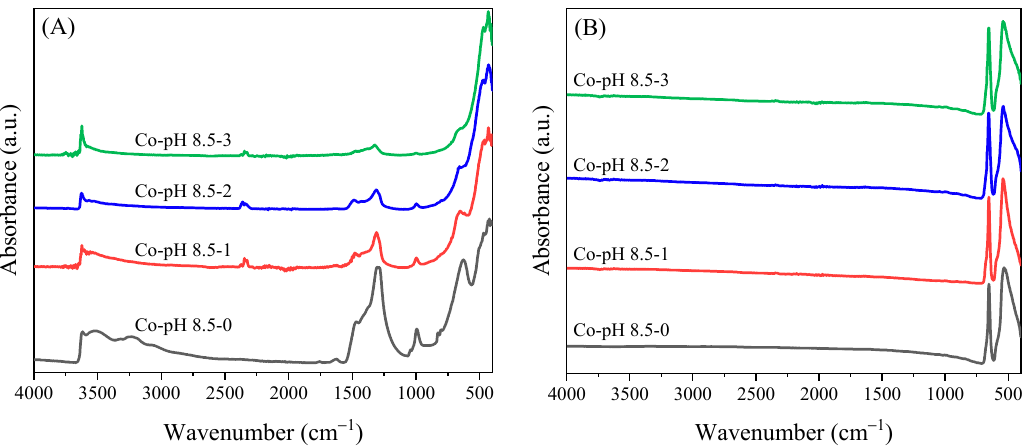
Figure 7. FTIR spectra of ( A ) cobalt precursors and ( B ) cobalt oxides prepared at pH 8.5 with di ff erent number of washings.